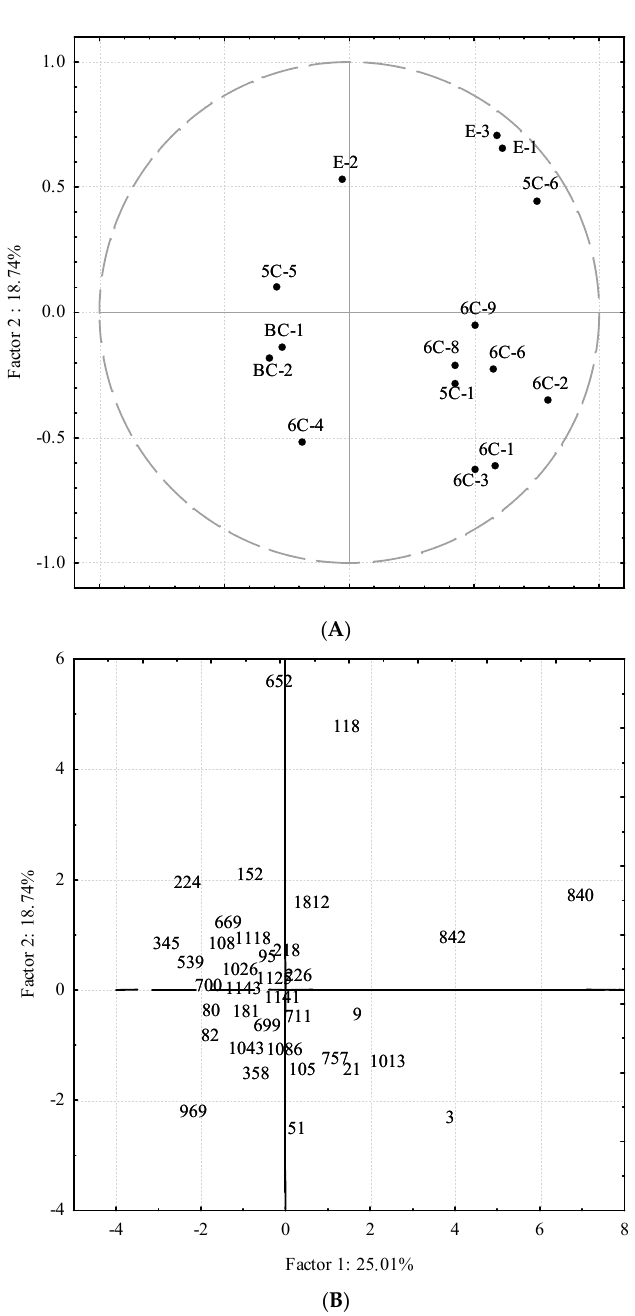
Figure 3. Bi-plot of selected volatile compounds contributing to the aroma (OAV > 1) of the Core-36 oils. ( A ) Vector distribution of the volatile compounds. Codes for the volatile compounds are listed in Table 2; and ( B ) distribution of the cultivars from the collection. References for the cultivars are listed in Table